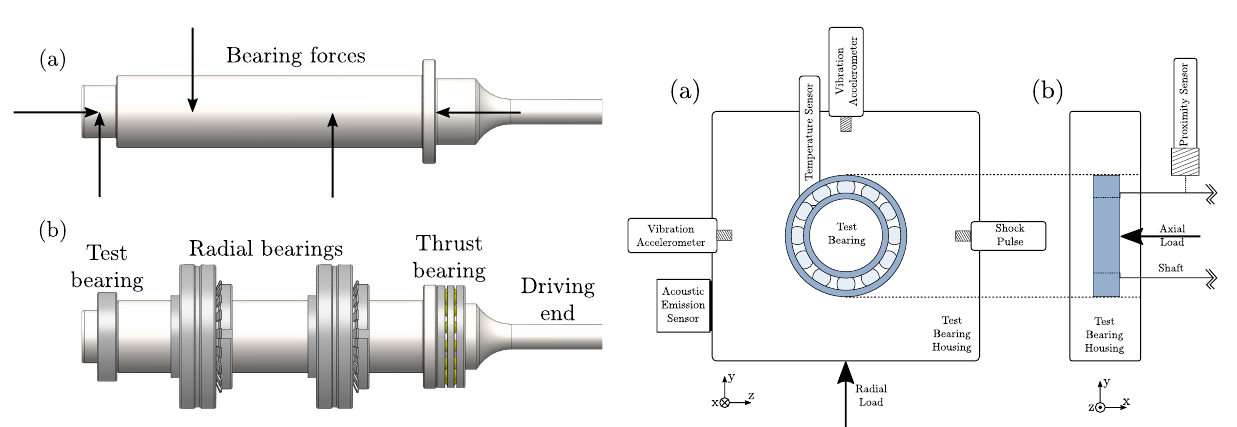
Figure 2: Chosen shaft design and bearing placements. (a) Counteracting forces on all the bearings. (b) Position of the required bearings.